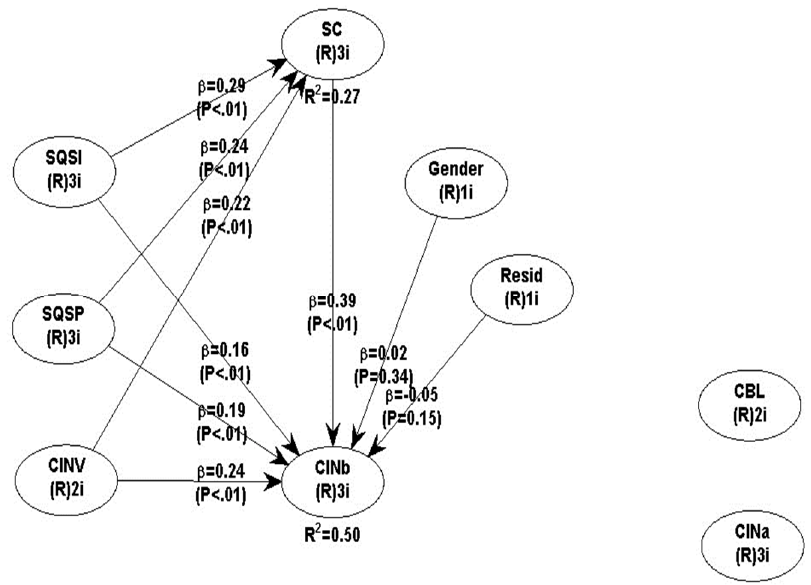
Figure A3. The third structural equation model—innovativeness awareness (CIN b ) is the outcome variable.